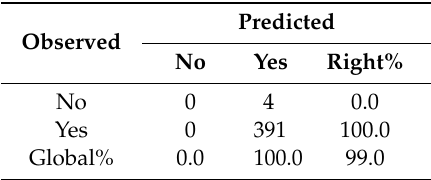
Table 14. Classification success for using WhatsApp.